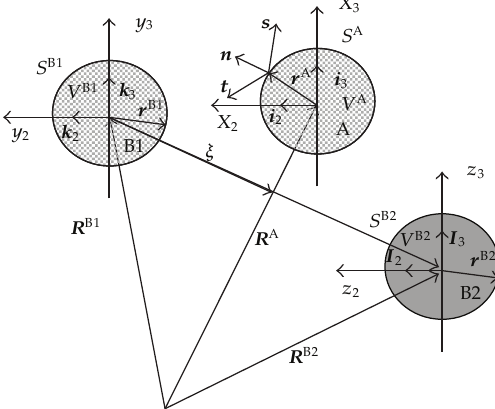
Figure 3: Geometrical relations for contact